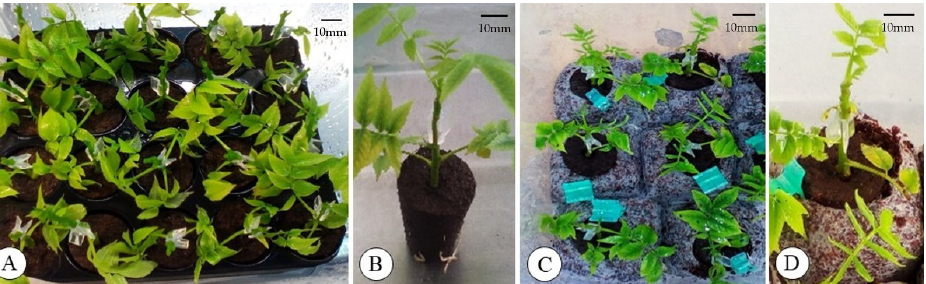
Figure 2. In vitro cultured explants during the multiplication phase